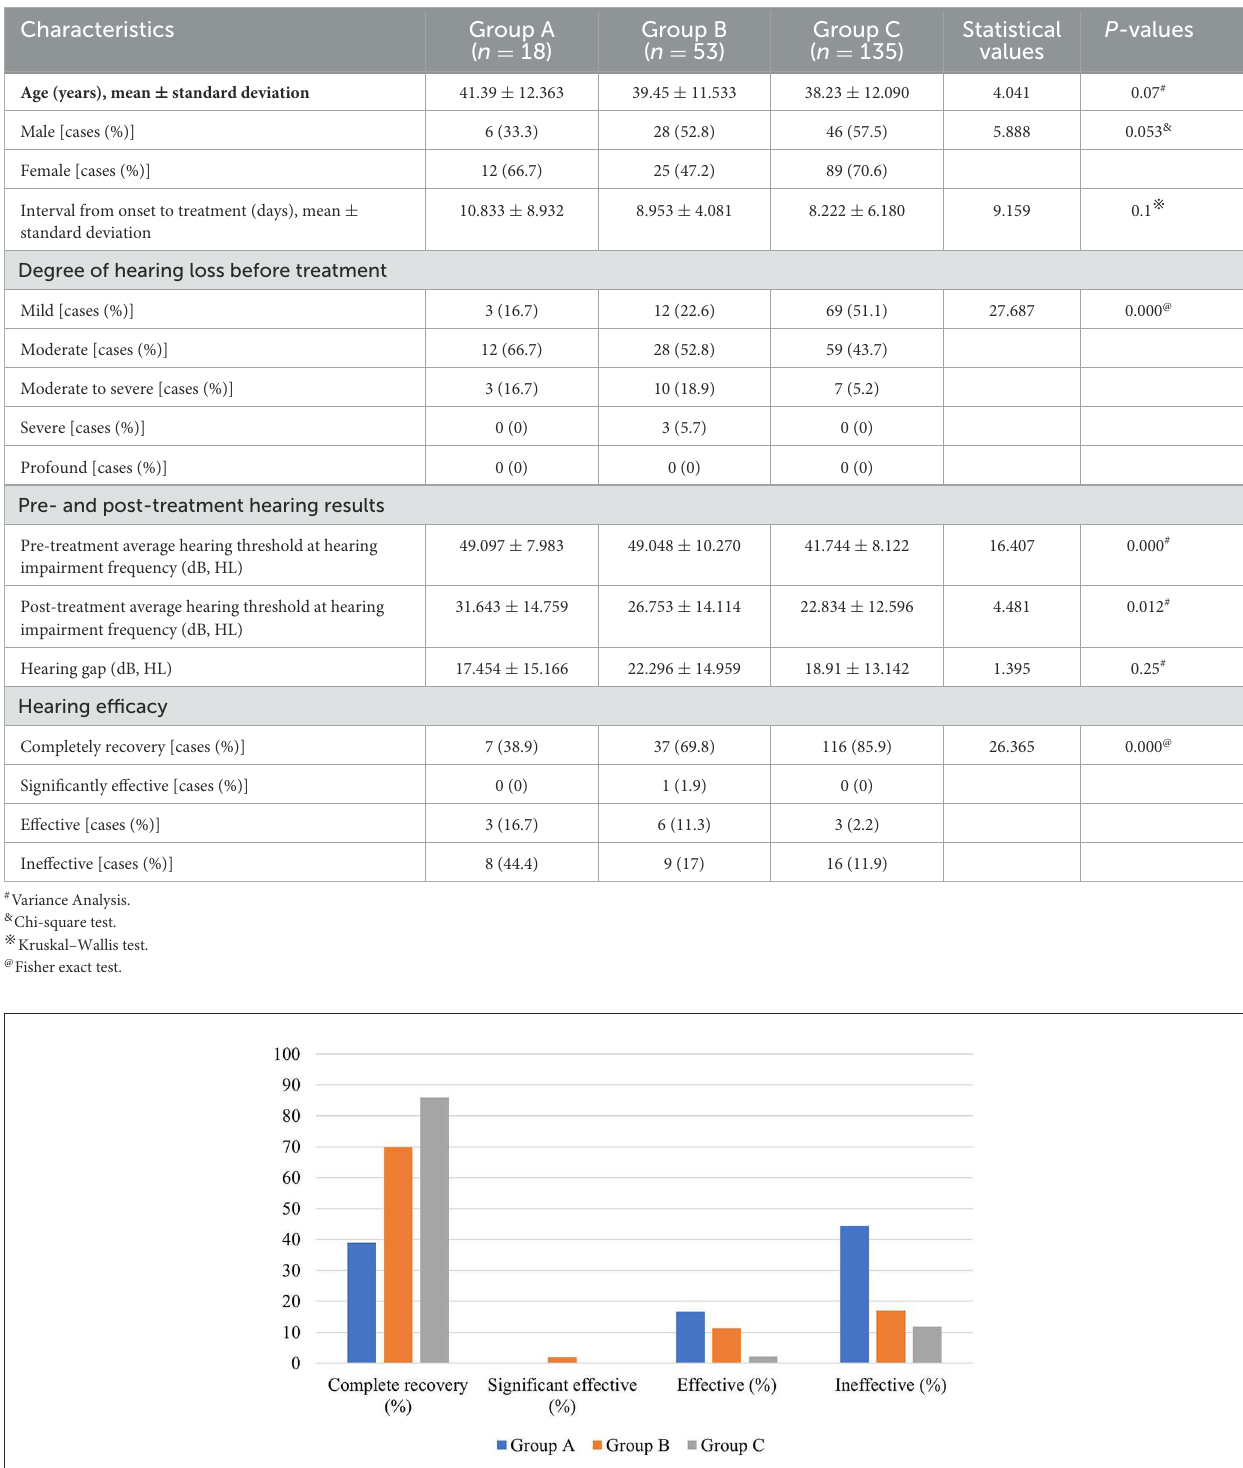
TABLE 4 Clinical characteristics and hearing efficacy of patients with ascending-type SSNHL in the three groups. Characteristics Group A